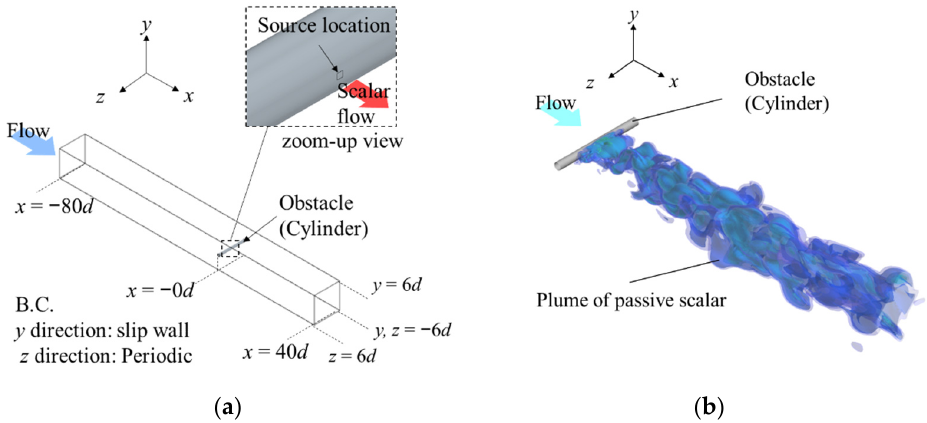
Figure 1. ( a ) Schematic for simulation model; ( b ) simulated plume of passive scalar.